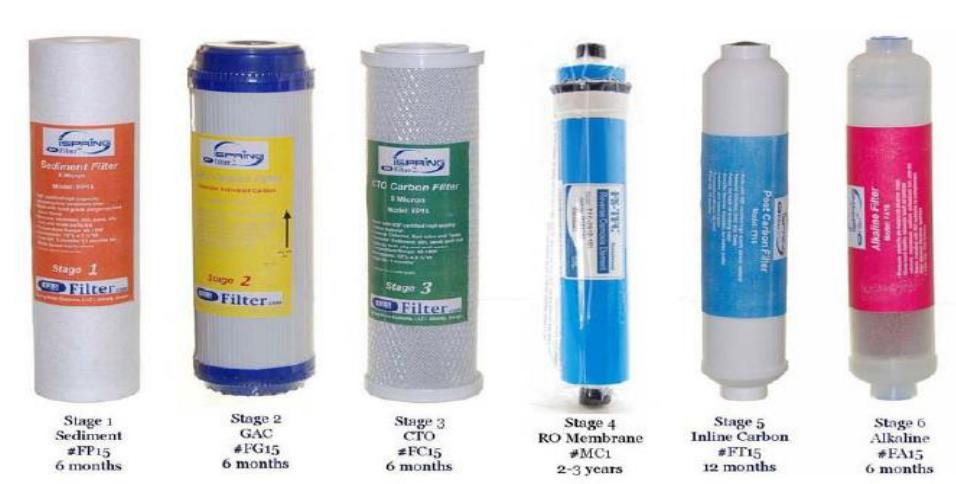
Figure 5. Six stage water filter